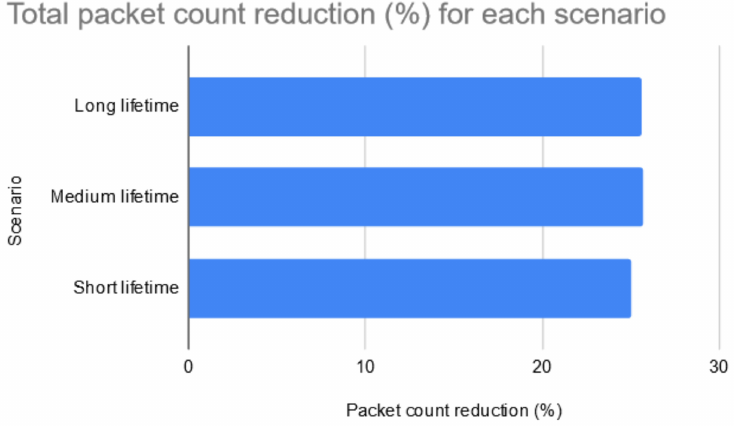
Figure 13. Gain in reducing the number of generated packets with no transmission